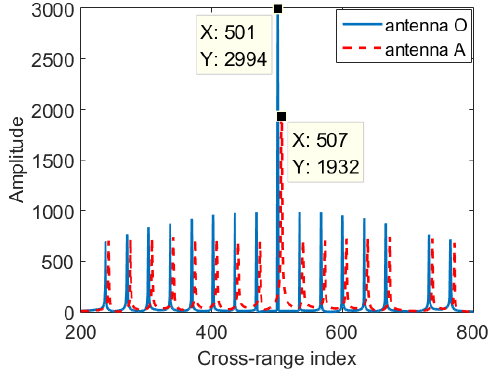
Figure 4. ISAR images at y = 0 of antenna O and antenna A before image registration.